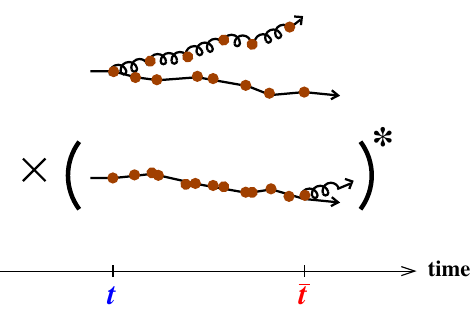
Figure 2 . Interference between high-energy bremsstrahlung at time t in the amplitude and time (cid:22) t in the conjugate amplitude, as the high-energy particles repeatedly scatter (represented by the brown dots) by small angles from the medium. In QCD, the particle represented by the non-curly line could be a quark or a gluon. For photon bremsstrahlung, photon scattering from the medium can be ignored.